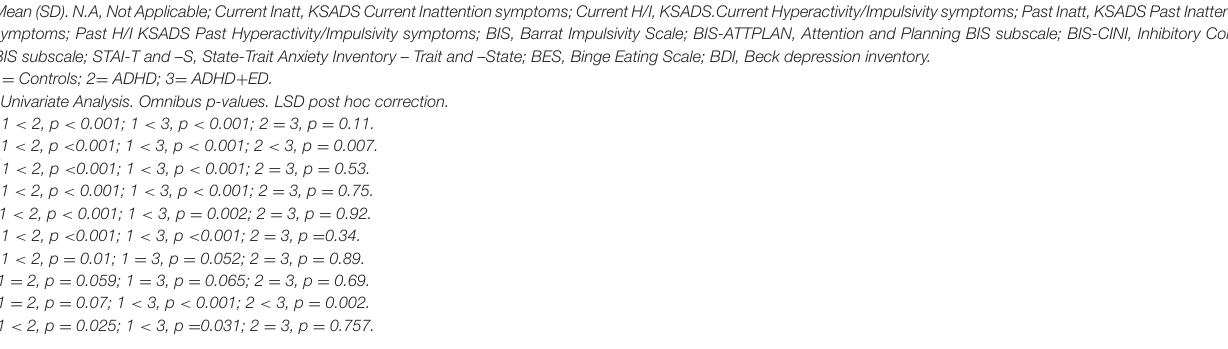
TABLE 3 | Interactions among groups for digit and visual span.